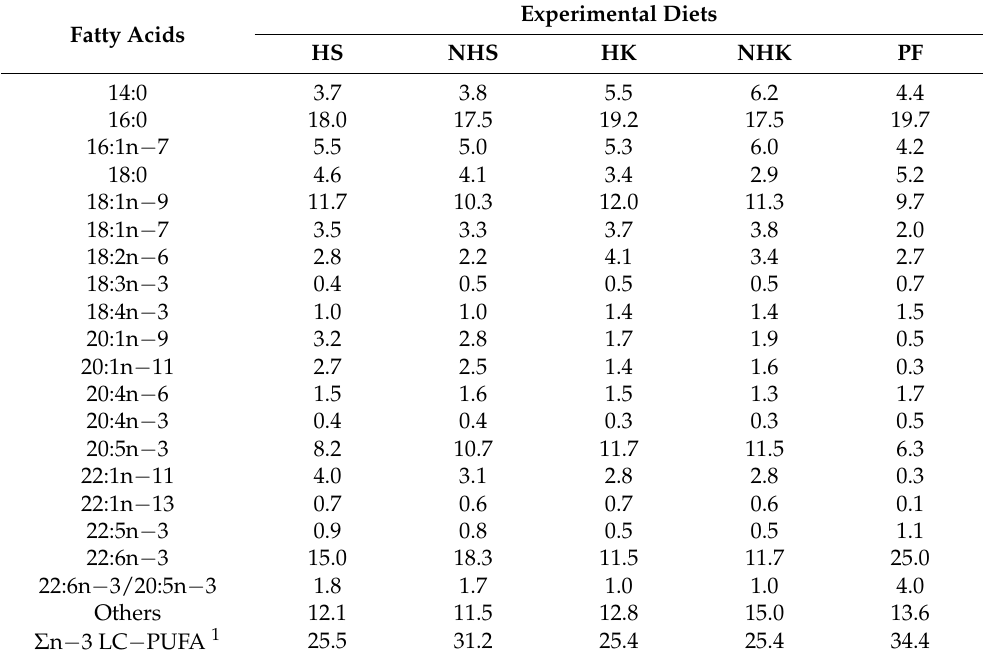
Table 4. Fatty acid composition (area% of total lipid) of the test diets. Fatty Acids